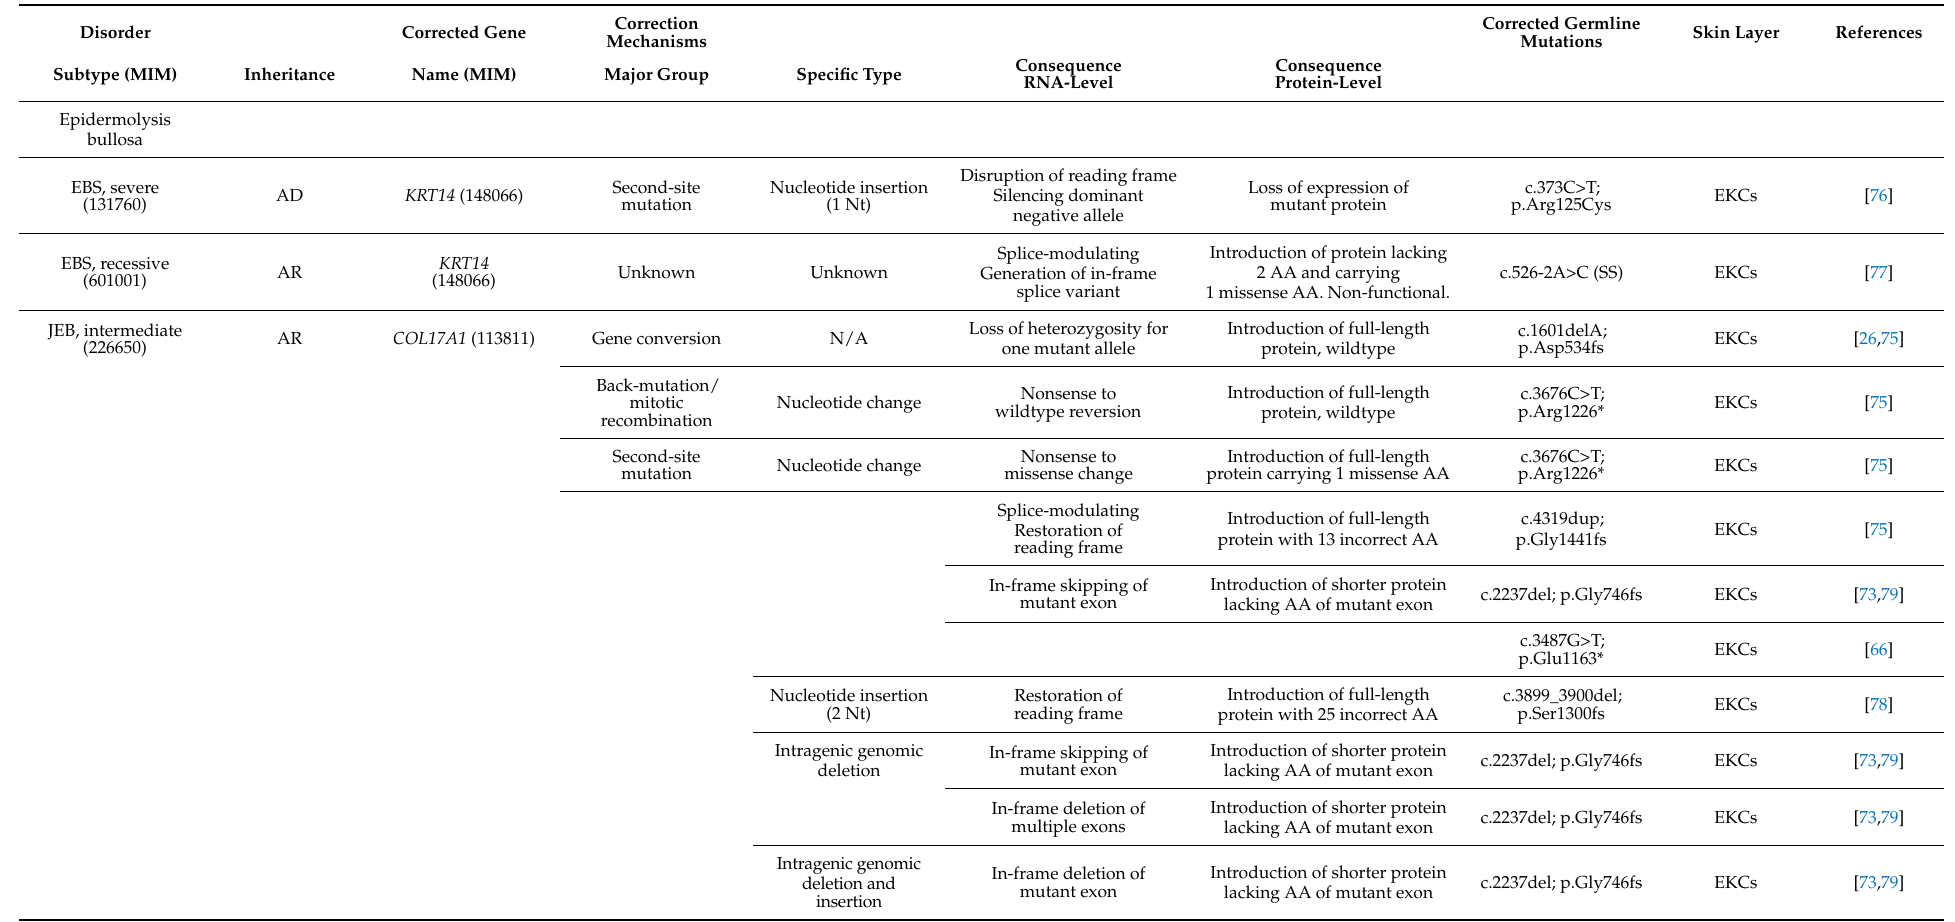
Table 1. Genetic correction mechanisms of revertant mosaicism reported in